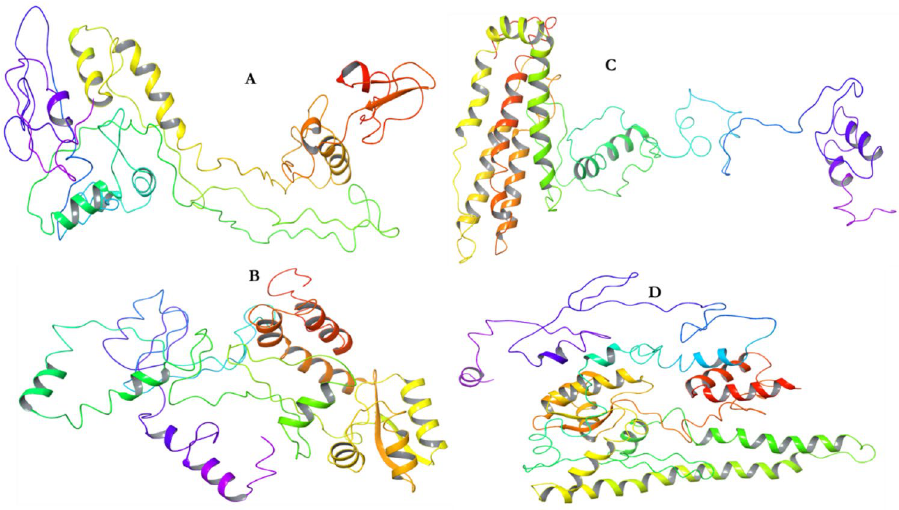
Figure 3. The predicted multi-epitope vaccines for DENV. A) DV-1; B) DV-2; C) DV-3; and ( D ) DV-4 as modelled by Schrödinger.